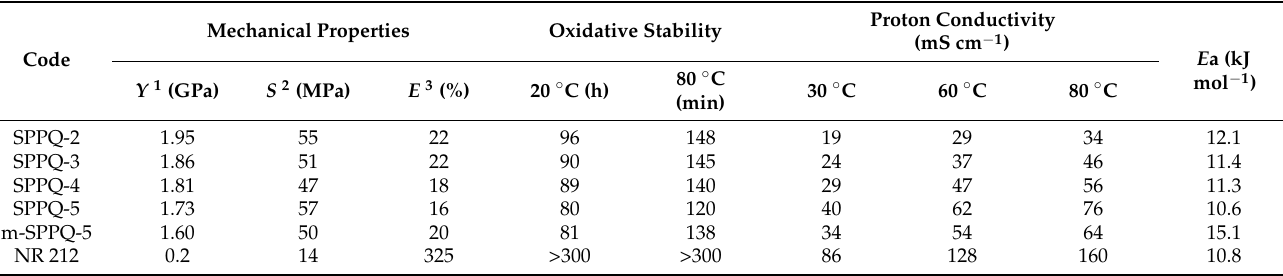
Table 4. Mechanical properties, oxidative stability and the proton conductivity of